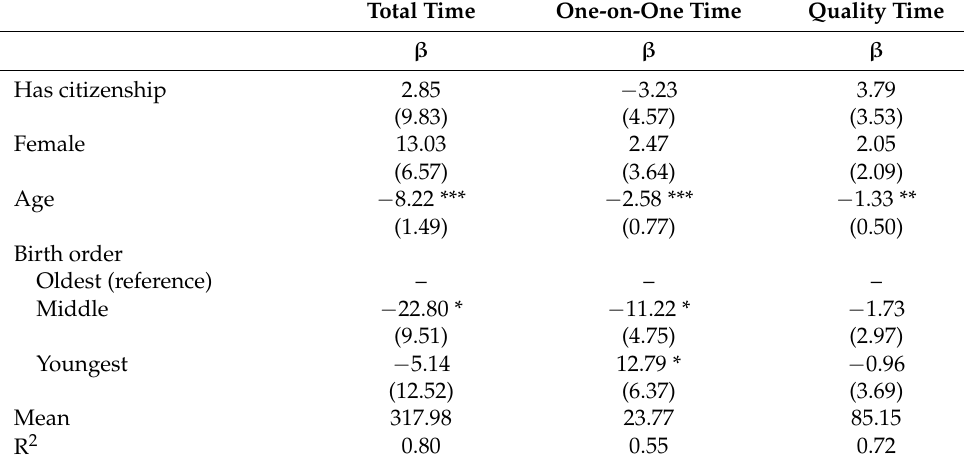
Table 4. Fixed Effects Within-family Sibling Comparisons of Parental Time Investments in Families where Siblings have Mixed Citizenship Status (N =